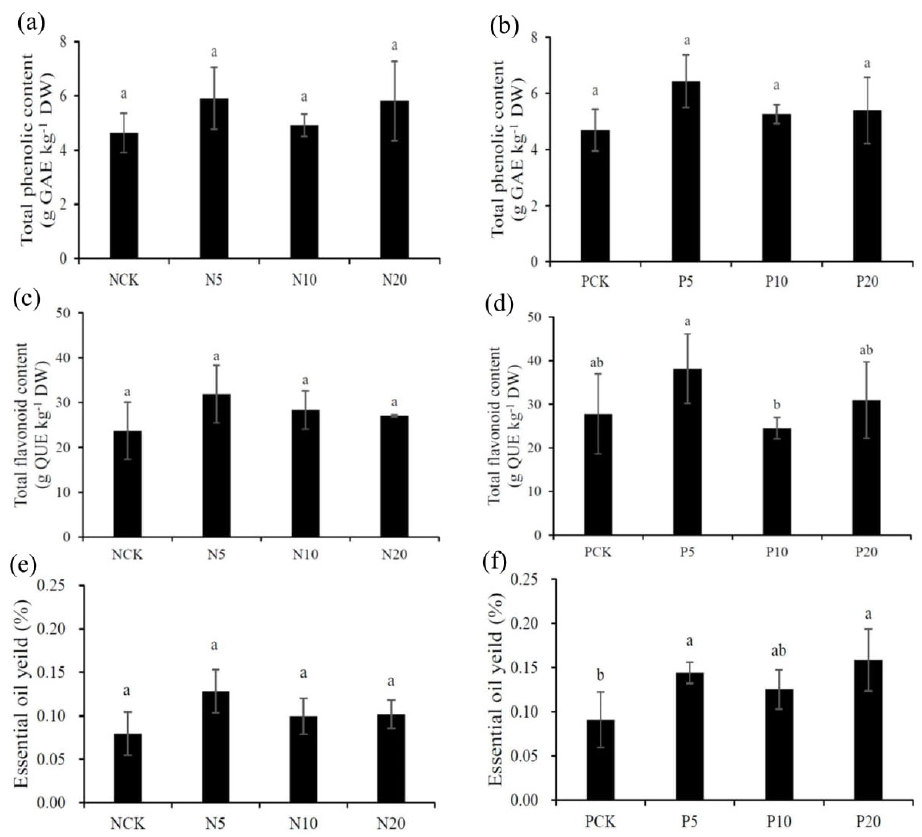
Figure 2. Effects of different fertilizer treatments on total phenolic and flavonoid contents, and essential oil yield in shoots of V. negundo . ( a , b ) Total phenolic content; ( c , d ) Total flavonoid content; ( e , f ) Essential oil yield. Error bars represent standard deviation ( n = 5), and bars with the same letter are not significantly different between treatments ( p < 0.05, Duncan’s multiple range